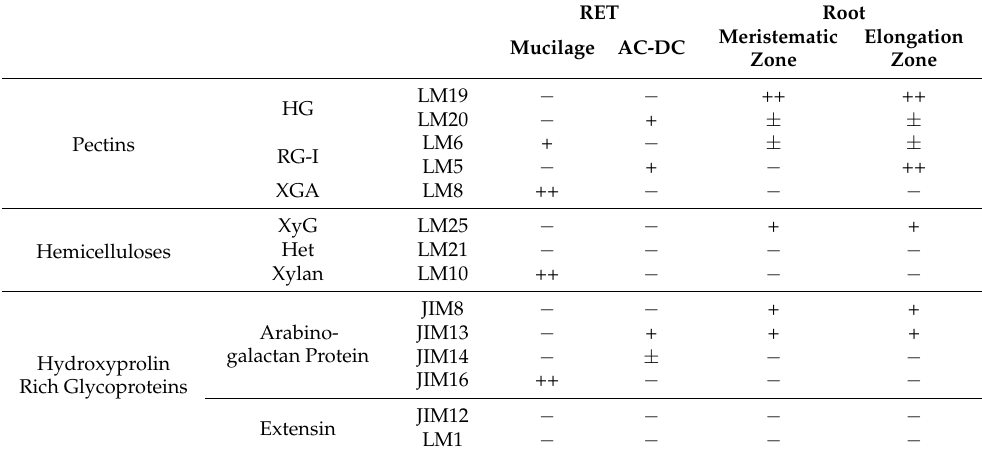
Table 1. Immunocytochemical characterization of glycopolymers of P. nigra RET and root tips. AC- DC: root associated cap derived cell, HG: homogalacturonan, RET: root extracellular trap, RG1: rhamnogalacturonan I, XGA: xylogalacturonan, XyG: xyloglucan, Het: heteromannan. (++)